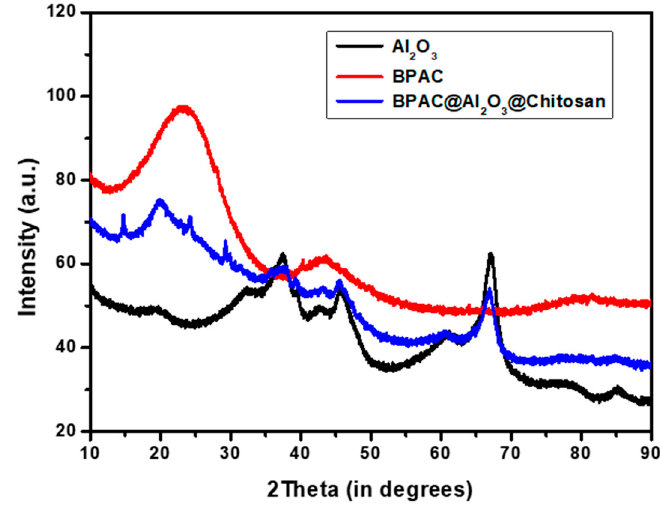
Figure 1. XRD spectra of BPAC, Al 2 O 3 , and BPAC@Al 2 O 3 @chitosan composite.